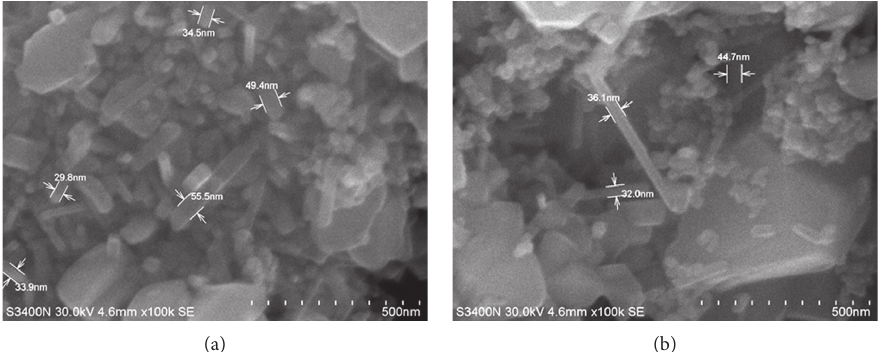
Figure 5: Crystallite size approximation obtained from high magnification SEM images of annealed under (a) 300 ° C and (b) 350 ° C of SnO